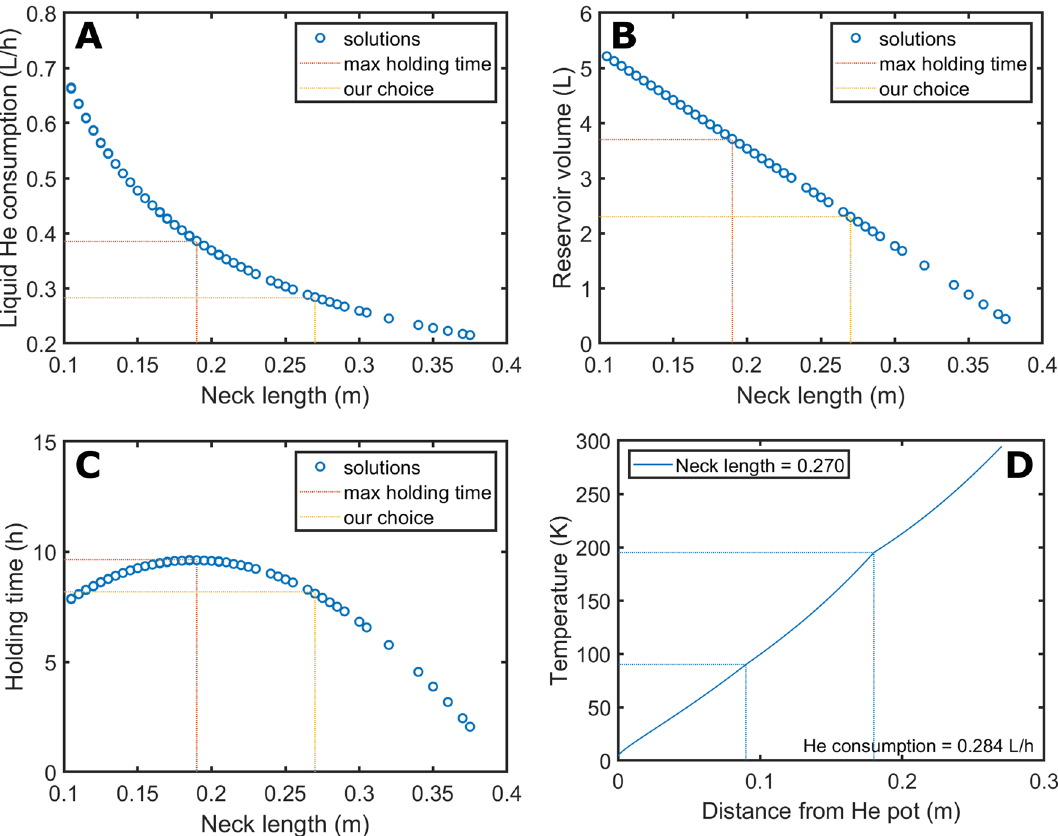
Figure 5. Liquid He consumption as a function of the cryostat neck length. The graph reports all gas flow value that solve Eq. (4), for a given length of the neck ( A ). All values of the neck length leading to a solution are used to calculate the consequent volume of the He pot ( B ). The ratio between He pot volume and consumption rate yields the maximum holding time as a function of the neck length ( C ). The orange and yellow dotted lines indicate the parameters corresponding to the maximum holding time and the choice we made to build the cryostat, respectively. The temperature profile of the configuration of choice without optimization of the positions of the radiation shields is reported in ( D